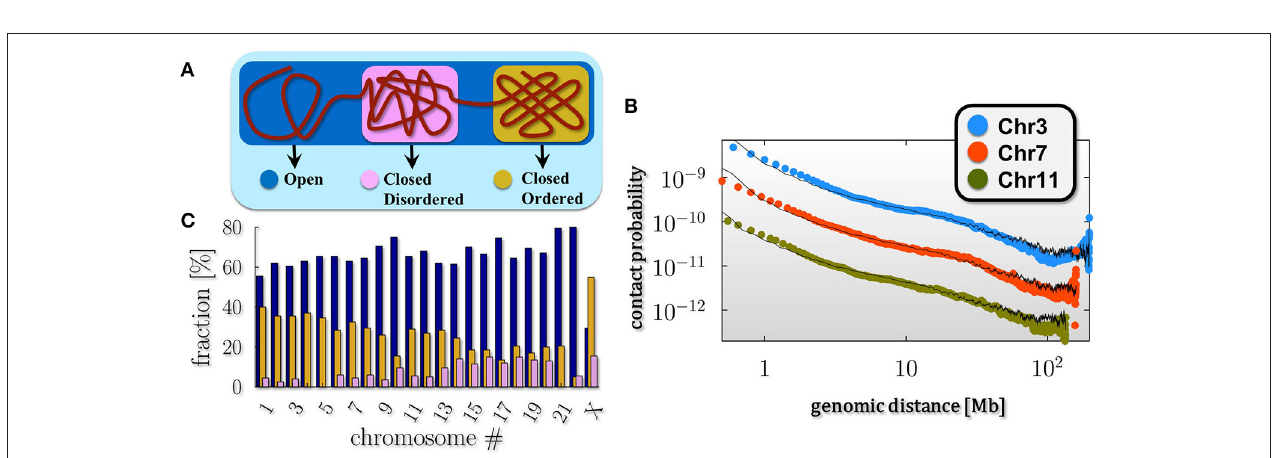
FIGURE 2 | Chromosomes are a mixture of differently folded regions. (A) The polymer mixture model of chromatin poses that a chromosome is a mixture of differently folded region, each belonging to the stable folding classes described by polymer physics (pure states), as discussed in Figure 1 . In this scenario the average pairwise contact frequency is determined only by the relative abundances of the pure states in the mixture. (B) Within such a model, the decay of the average pairwise contact data as a function of genomic separation of single chromosomes from in-situ Hi-C data in fibroblast (IMR90) cells (data from Rao et al., 2014) can be fitted over three orders of magnitudes in genomic separation. (C) The barplot shows the relative composition of the pure states across the different chromosomes for the IMR90 cell line: chromosome richer in genes, such as chr17 or chr19, result to be composed, for the most part, by open regions (up to 70%), while chromosome X, as expected, has a more compact conformation compared to the other chromosome, with percentage of closed state above the